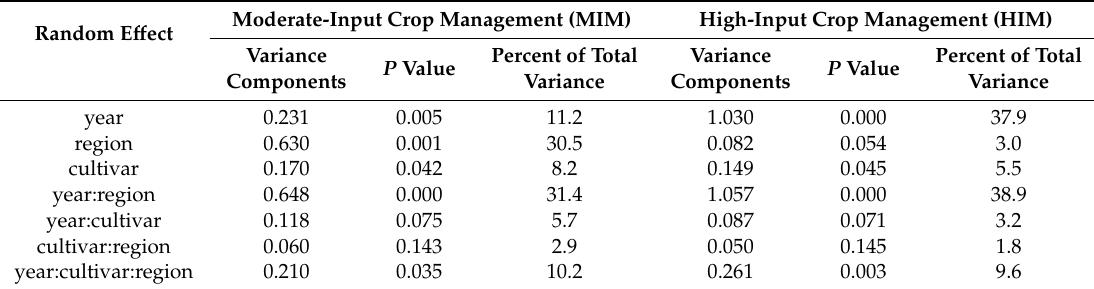
Table 3. The variance components of triticale grain yield for studied random e ff